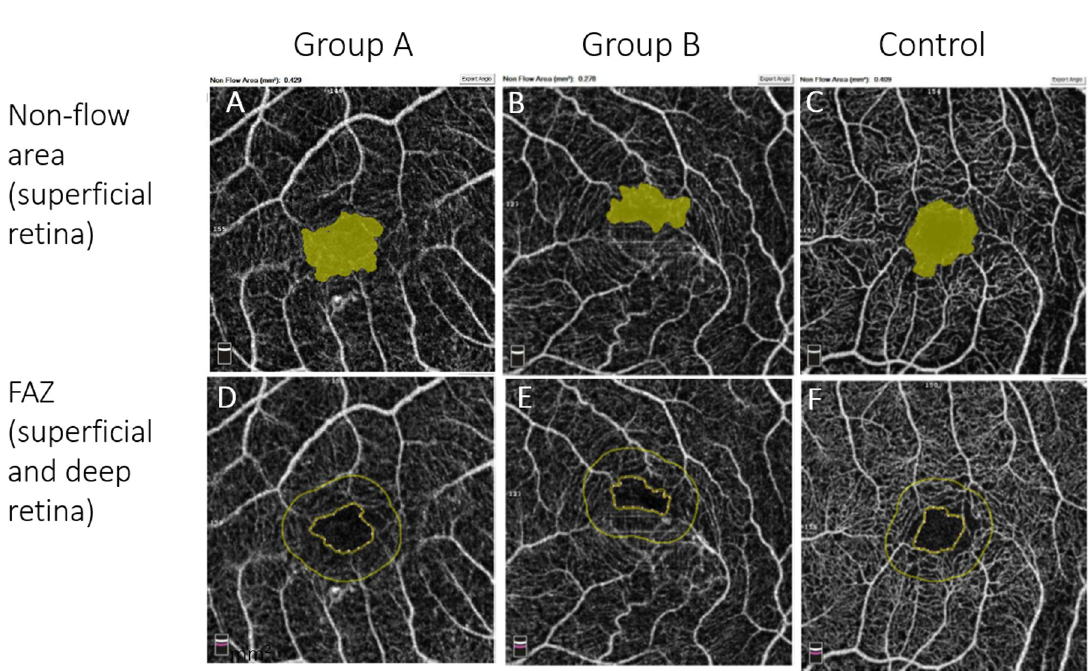
Fig 3. OCT-A imaging of the foveal avascular zone (A-C, FAZ), and the non-flow area (D-F). The areas are calculated by the automated AngioAnalytics software. Note the greater FAZ and non-flow areas in Group A (first column), B (second column) compared to the control group (third